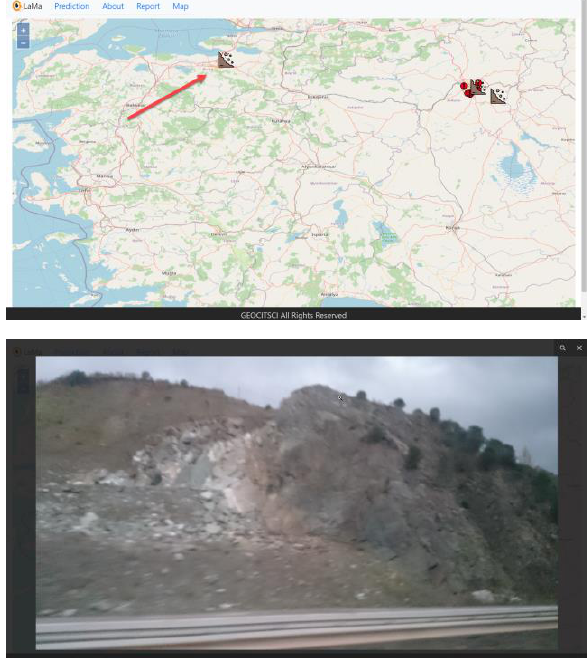
Figure 9. An example to the user-provided landslide photograph (below) together with its location (above). The photo was also classified as landslide in the image classifier.